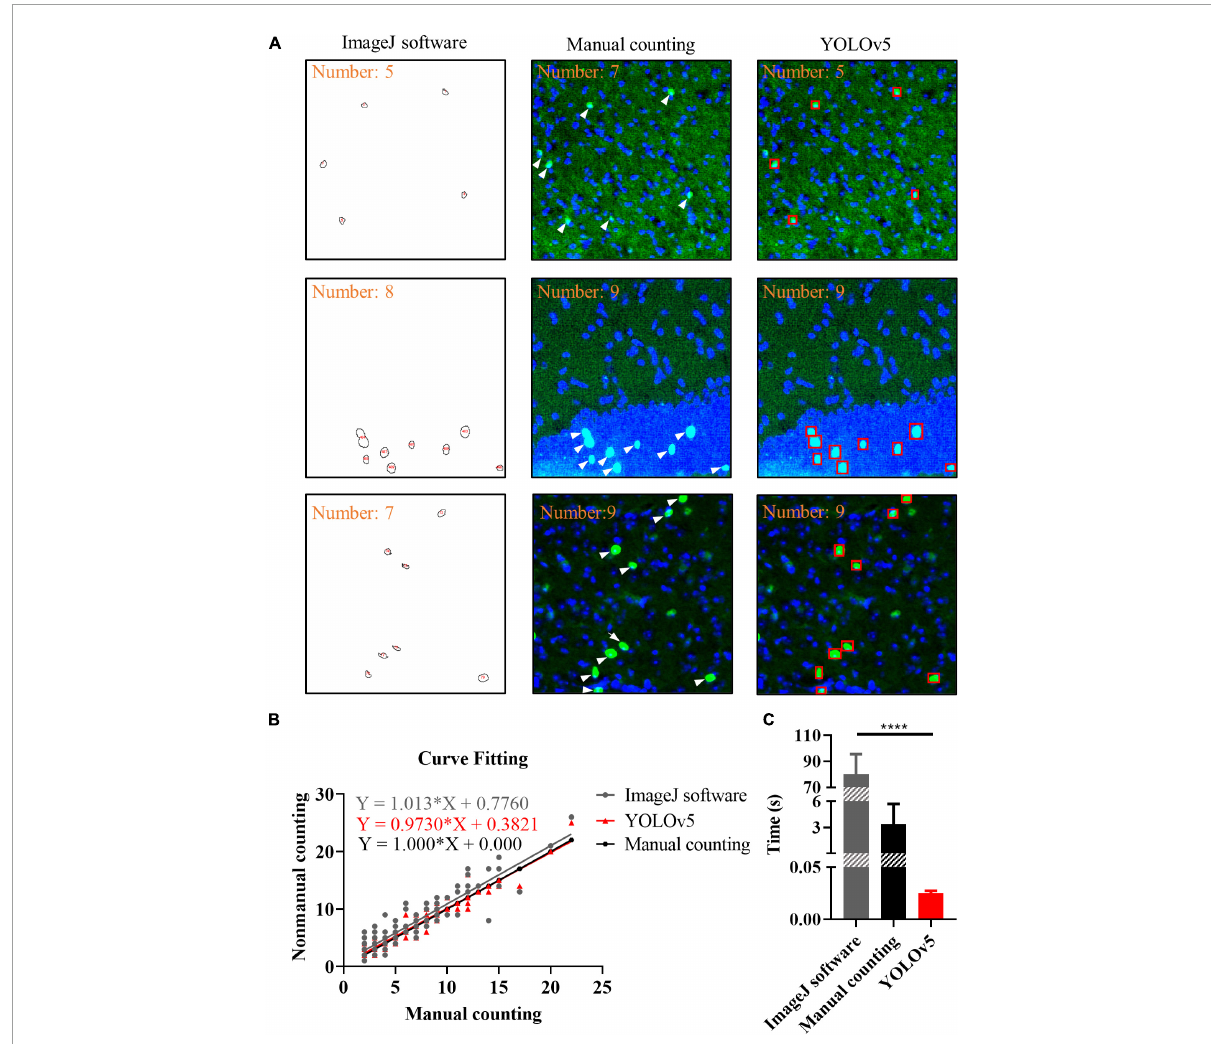
FIGURE6 Results of different recognition methods. (A) Representative images of c-Fos recognition processed by ImageJ software (closed circles), manual counting (white arrows) and you-only-look-once-v5 (YOLOv5) (red boxes). (B) Curve fitting between different methods. The dots show the data and lines represent fitting curves. (C) Processing time for different methods. The data shown represent the mean ± SD values for the indicated n . **** p < 0.0001, from an independent samples t